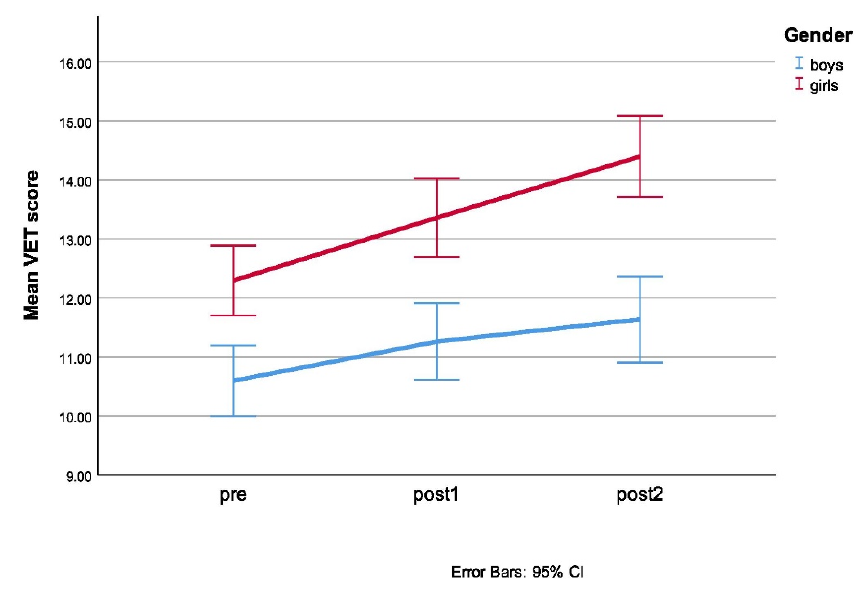
Figure 2. Mean VET scores for girls and boys at different measurement points .